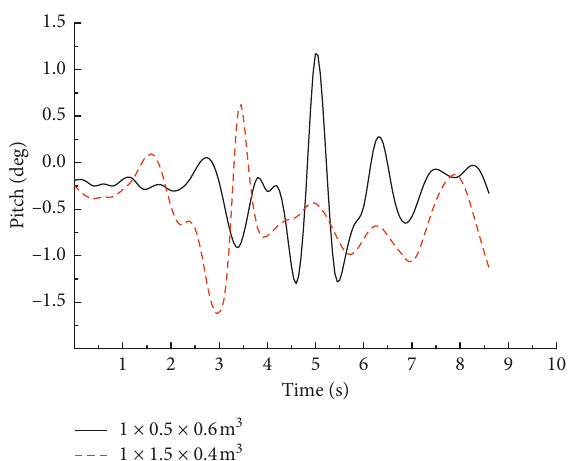
Figure 17: Time history curve of the pitching motion of the ship under different numbers of landslides. The labels are length, width and thickness in sequence, such as the length is 1 m, the width is 0.5m, and the thickness is 0.6